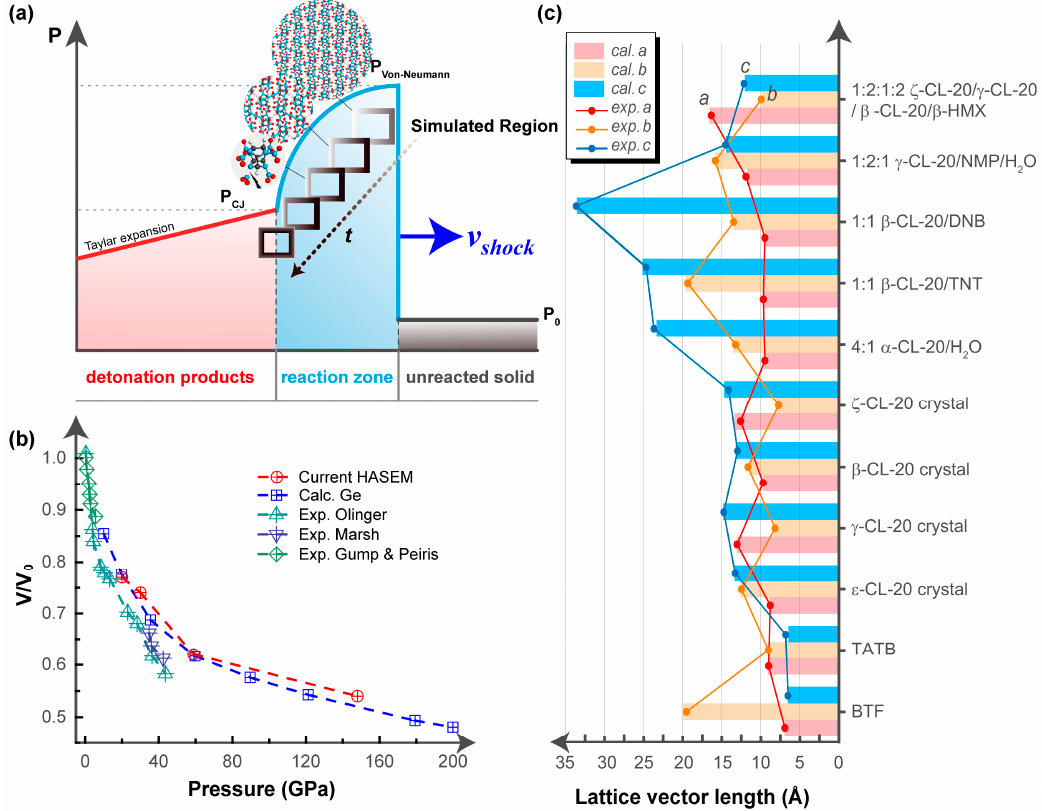
Figure 1. Dynamics simulation method of shock wave tests. ( a ) Schematics of the simulation method. ( b ) Validation of the code by comparing the Hugoniot curve of a single crystal model of octogen (HMX) single crystal to the reported experimental and calculational results in the literature. ( c ) Accuracy verification of the code by comparing the lattice lengths of the studied eleven energetic single crystals to the experimental values obtained by X-ray crystallography.